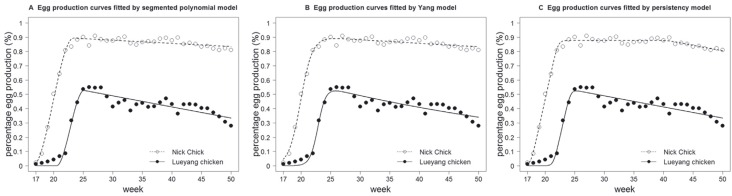
Average weekly egg production rate and fitted egg production curves for
Lueyang and Nick Chick chickens.